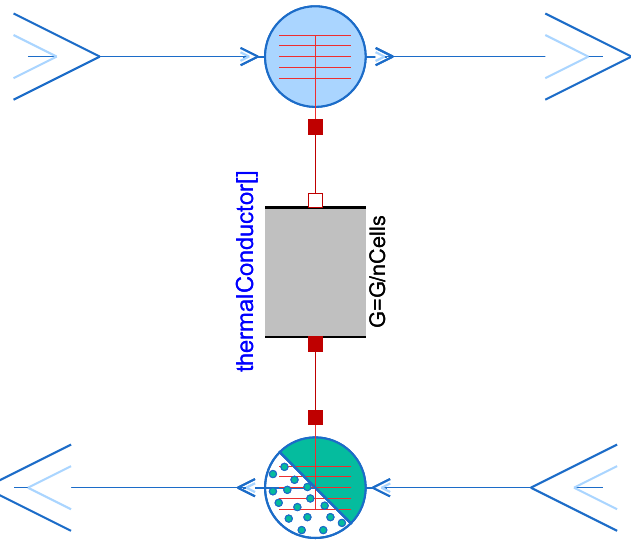
Figure 3. Cell model of discretized heat